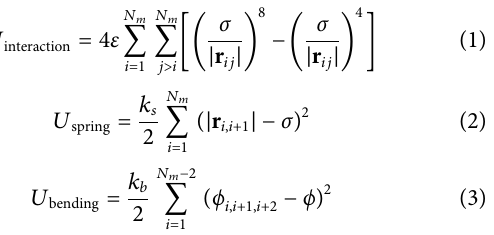
TABLE 1 | List of model parameters and corresponding ranges of values used in simulations. Parameter Description Range of